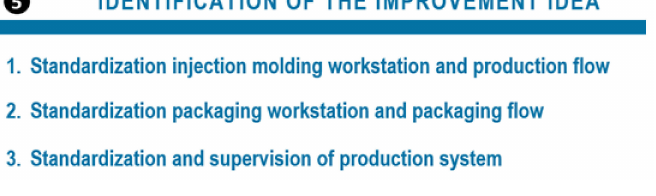
Figure 20. Improvement ideas of the production system “plastic